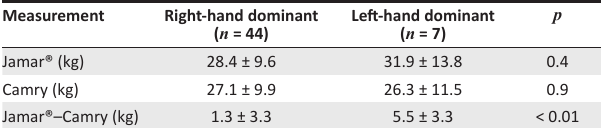
respective devices. The results on the Camry were digital; the grip strength was recorded accurately up to one decimal